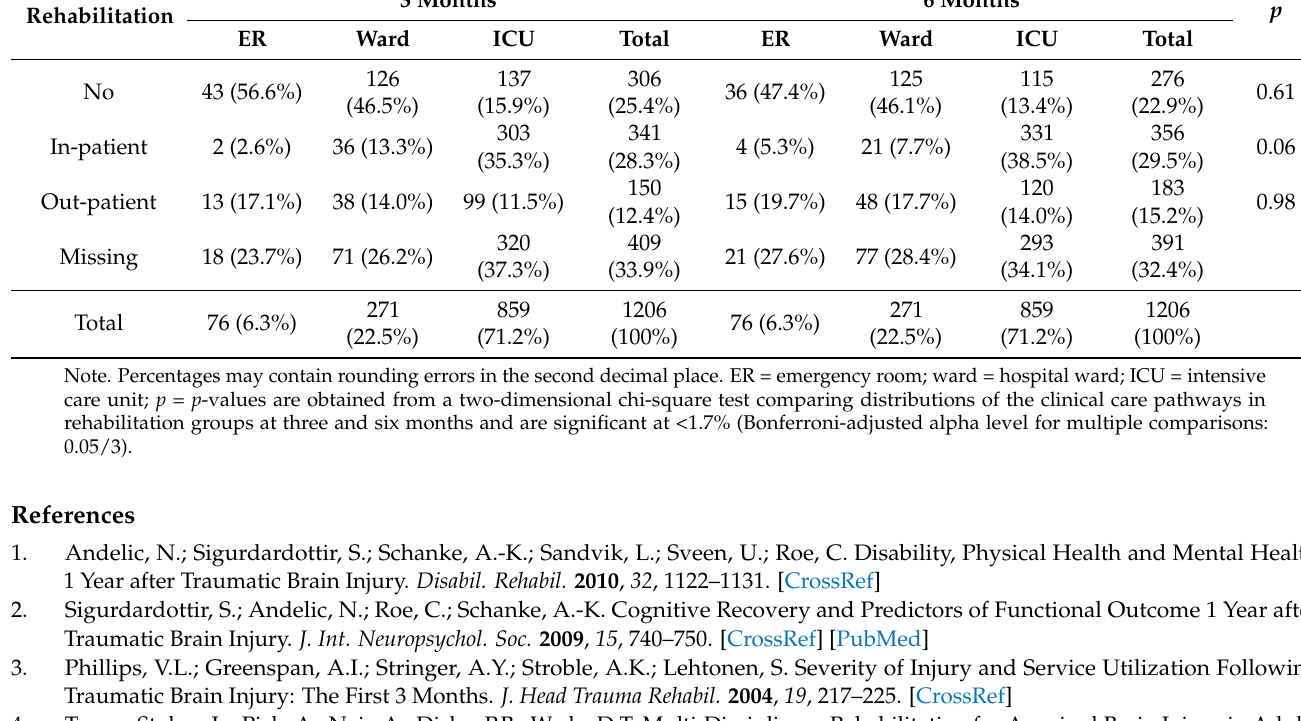
Table A1. In- and out-patient rehabilitation provided at 3 and 6 months after TBI by clinical pathways.